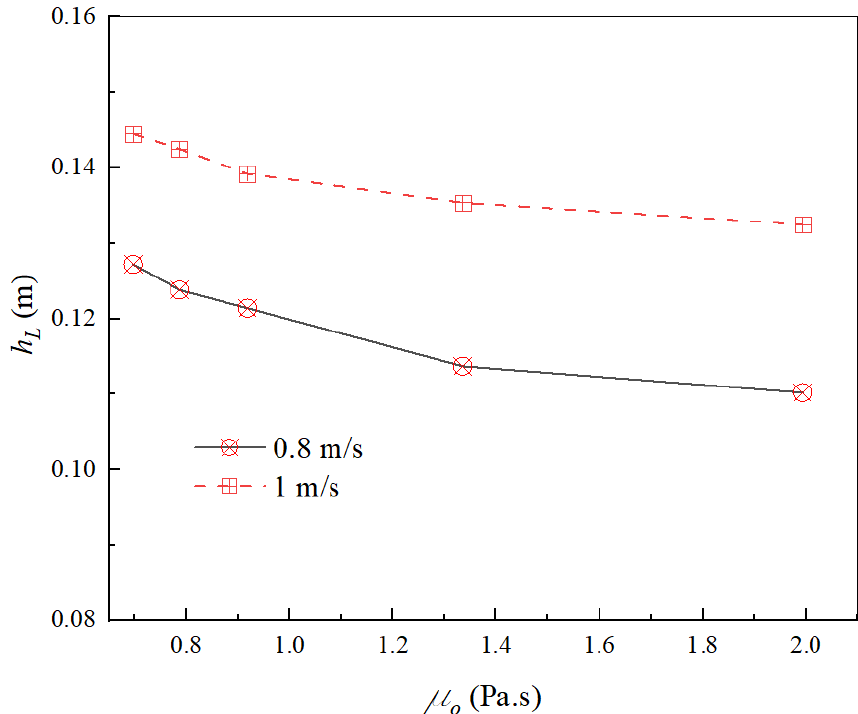
Figure 15. The head loss of oil–water annular flow with different oil viscosities. Table 2. Physical properties of non-Newtonian oil [41] and h L